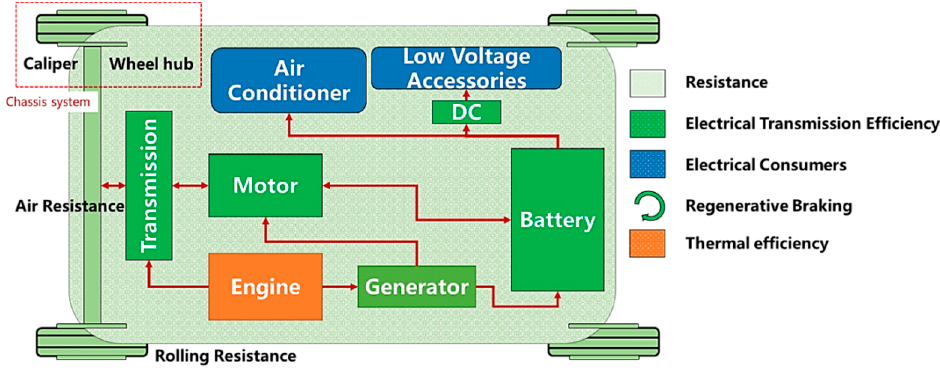
Figure 1. Simple structure of the series-parallel hybrid system.